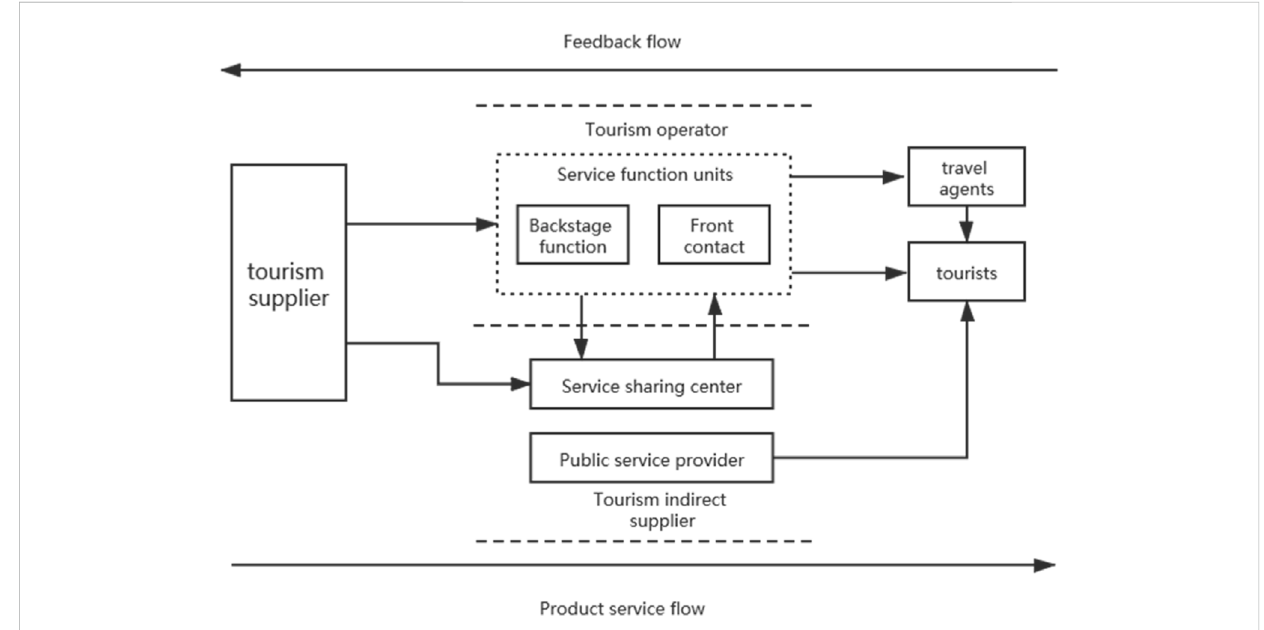
FIGURE 1 Front – background separation structure of the all-for-one tourism supply